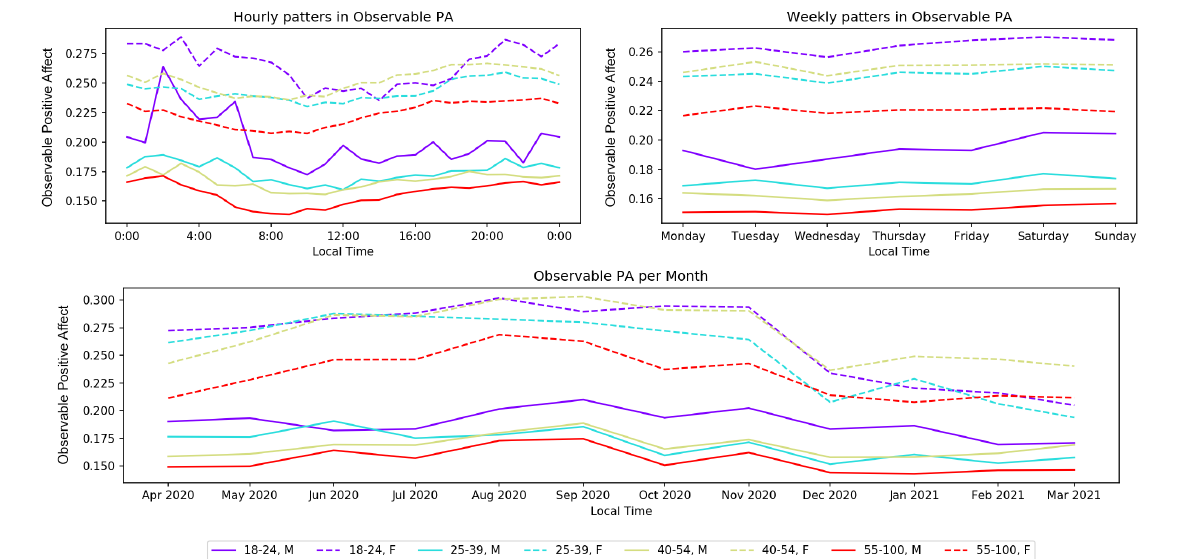
Figure 7. Observable PA for demographic groups in local